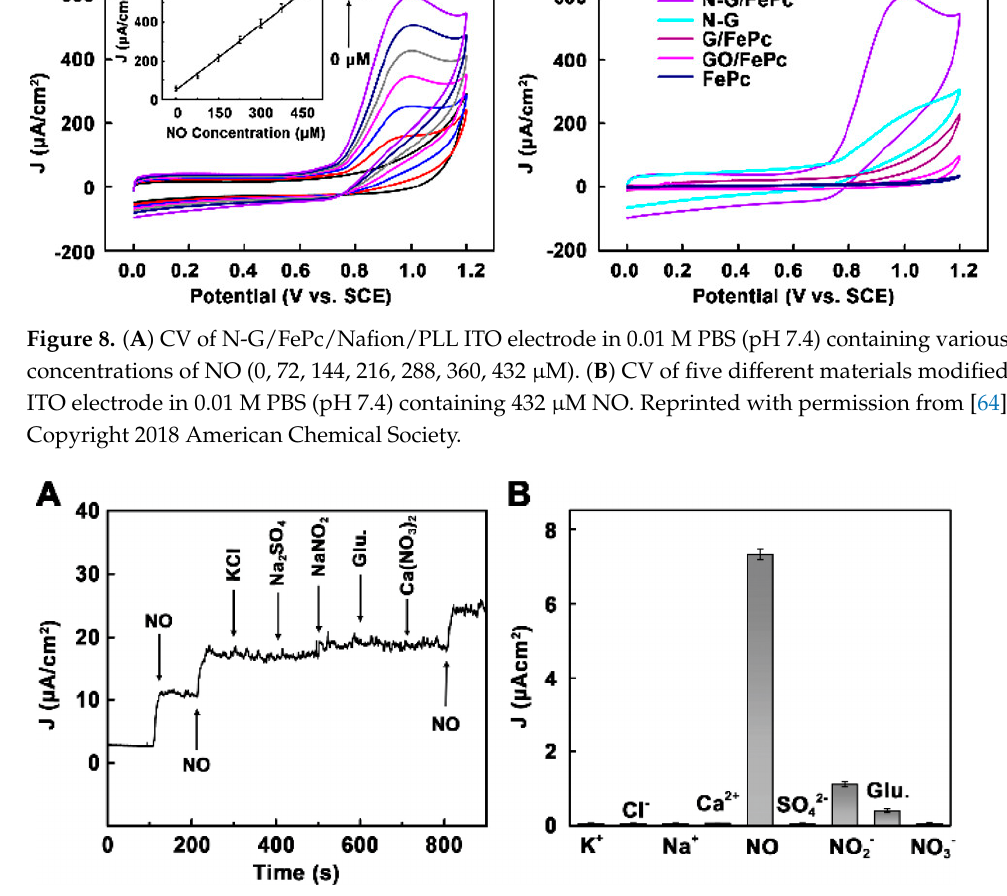
Figure 9. ( A ) Amperometric responses to 36 μ M NO, KCl, Na 2 SO 4 , NaNO 2 , glucose and Ca(NO 3 ) 2 . ( B ) The selective profile. Reprinted with permission from [64]. Copyright 2018 American Chemical